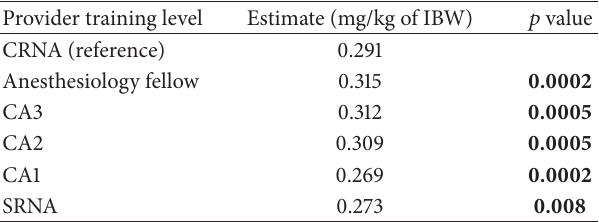
Table 3: Univariate linear mixed effects model using provider expe- rience and training level as a predictor for rocuronium maintenance dose in mg/kg of IBW. More inexperienced providers (CA1s and SRNAs) tended to give smaller doses than their more experience